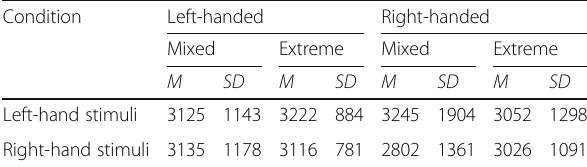
Table 2 Descriptive statistics for reaction time of